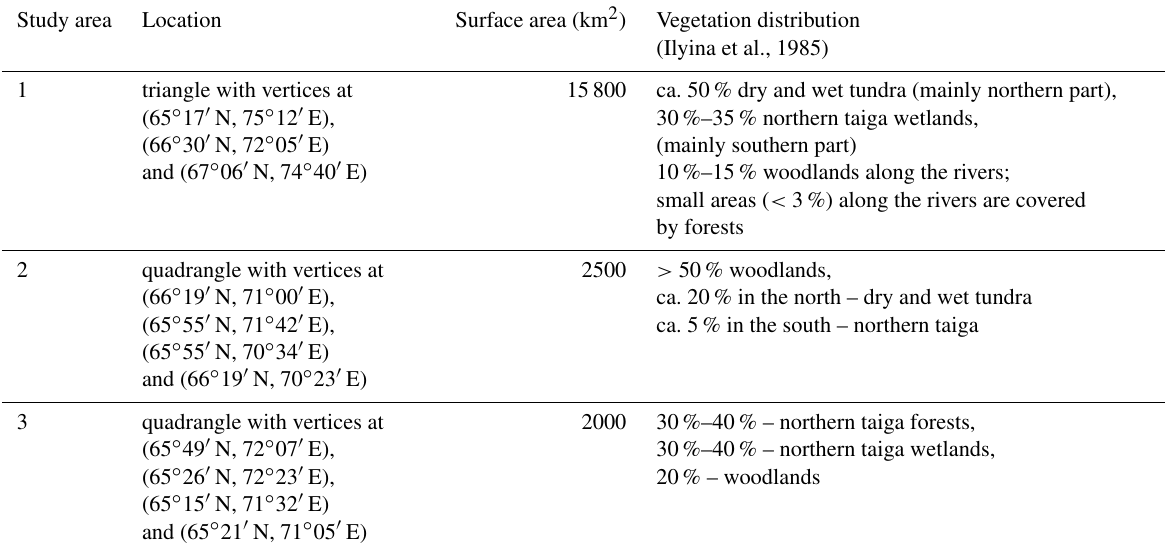
Table 1. Description of the study areas. Classification of the study areas according to vegetation types. Study area